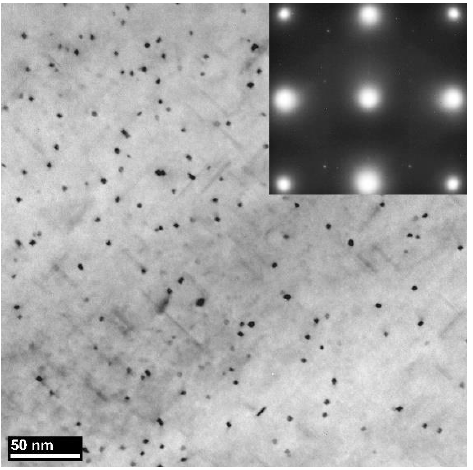
Figure 15. Microstructure of rheocast AlSi9Cu3(Fe) alloy after peak ageing treatment at 180 °C; SAED pattern in the inset.